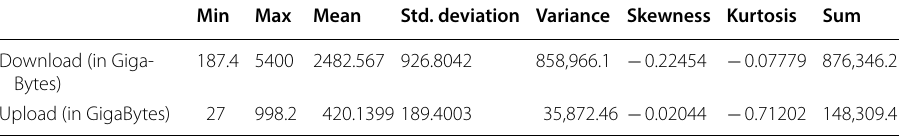
Table 2 Descriptive statistics of the internet traffic data for the year 2017